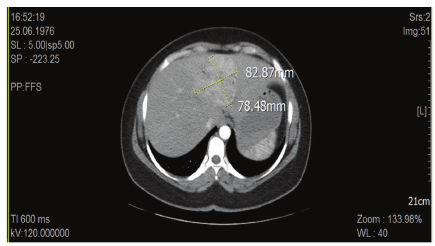
Figure 1: CT appearance of the tumor in the liver (CT image of hepatic mass).